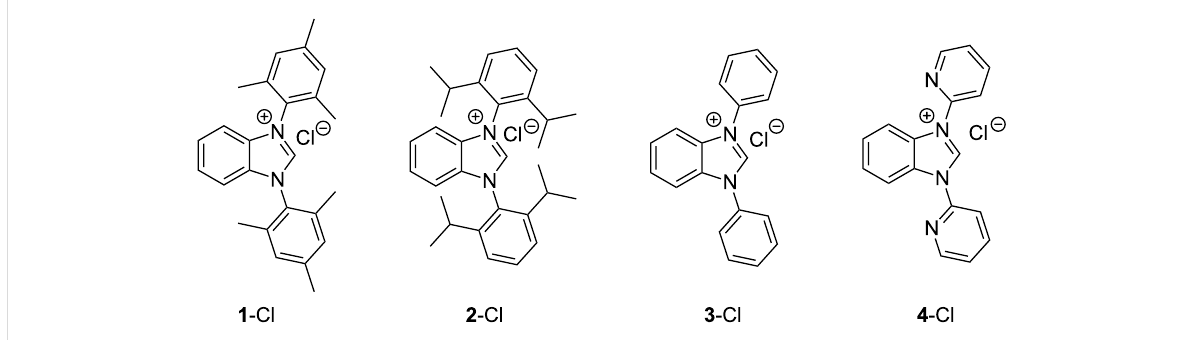
Figure 2: Benzannulated NHCs of this work. Benzannulated imidazolium chloride salts 1 -Cl, 2 -Cl, 3 -Cl and 4 -Cl of various steric demands and ligating properties in complexes.